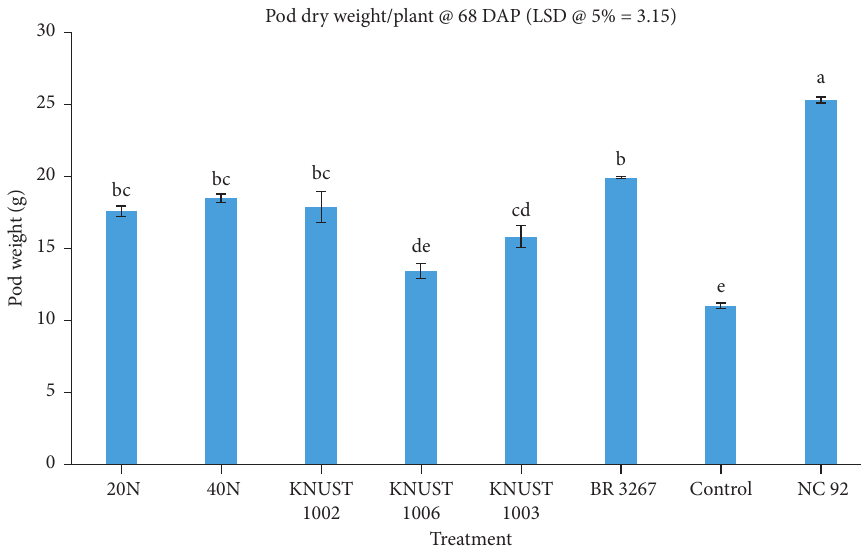
Figure 1: Effects of rhizobial inoculation and N fertilizer application on pod dry weight per groundnut plant. Bars with different letters denote significance at P < 0 . 05. Error bars denote the standard error of means. Means comparison was conducted using least significant difference.